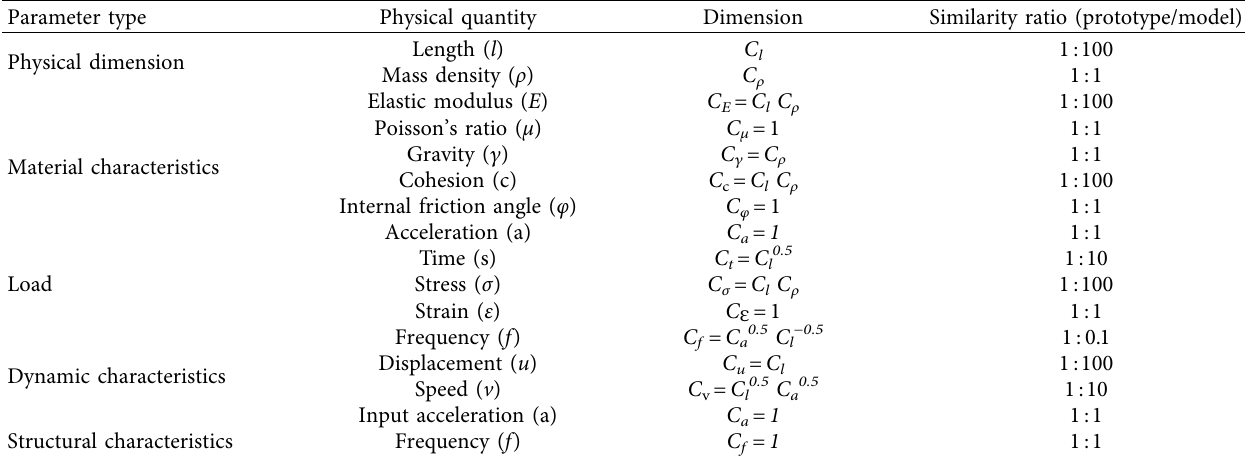
Table 2: Scale factor.